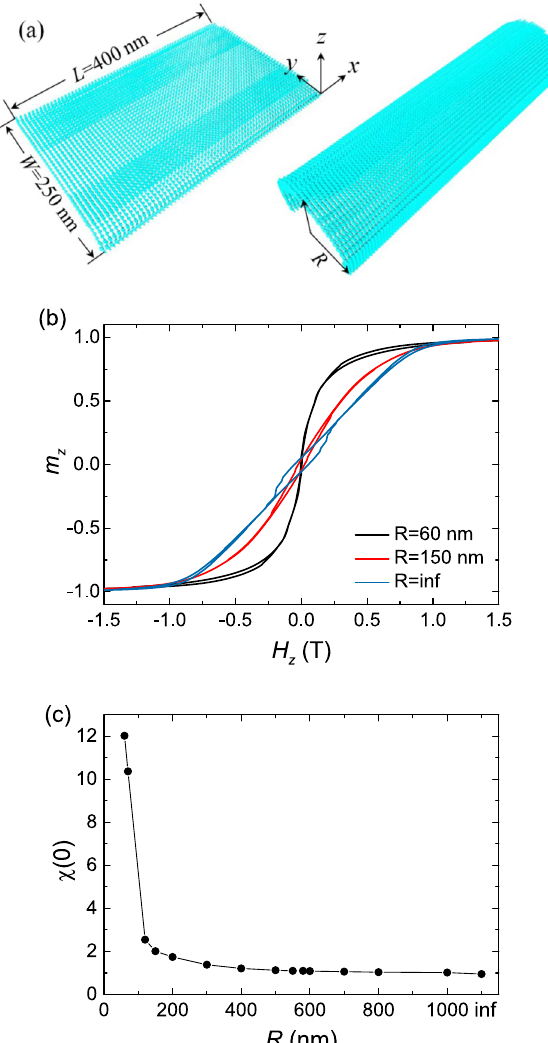
Figure 5. ( a ) The sketch of the curved film. The size of the film is fixed at length of 400 nm, width of 250 nm, and thickness of 10 nm. Then, it is curved to a circularly curved film with a fixed radius R , where R varies from 40 nm to infinity. ( b ) The hysteresis loops for the curved films with R = 60, 150 and inf, respectively. ( c ) The susceptibility at H z = 0 as a function of R